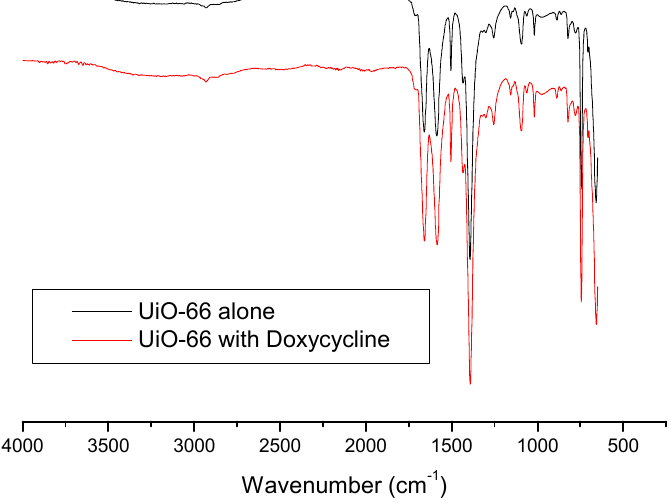
Figure 7. FTIR spectra for fresh UiO-66 and Doxycycline-filled UiO-66.